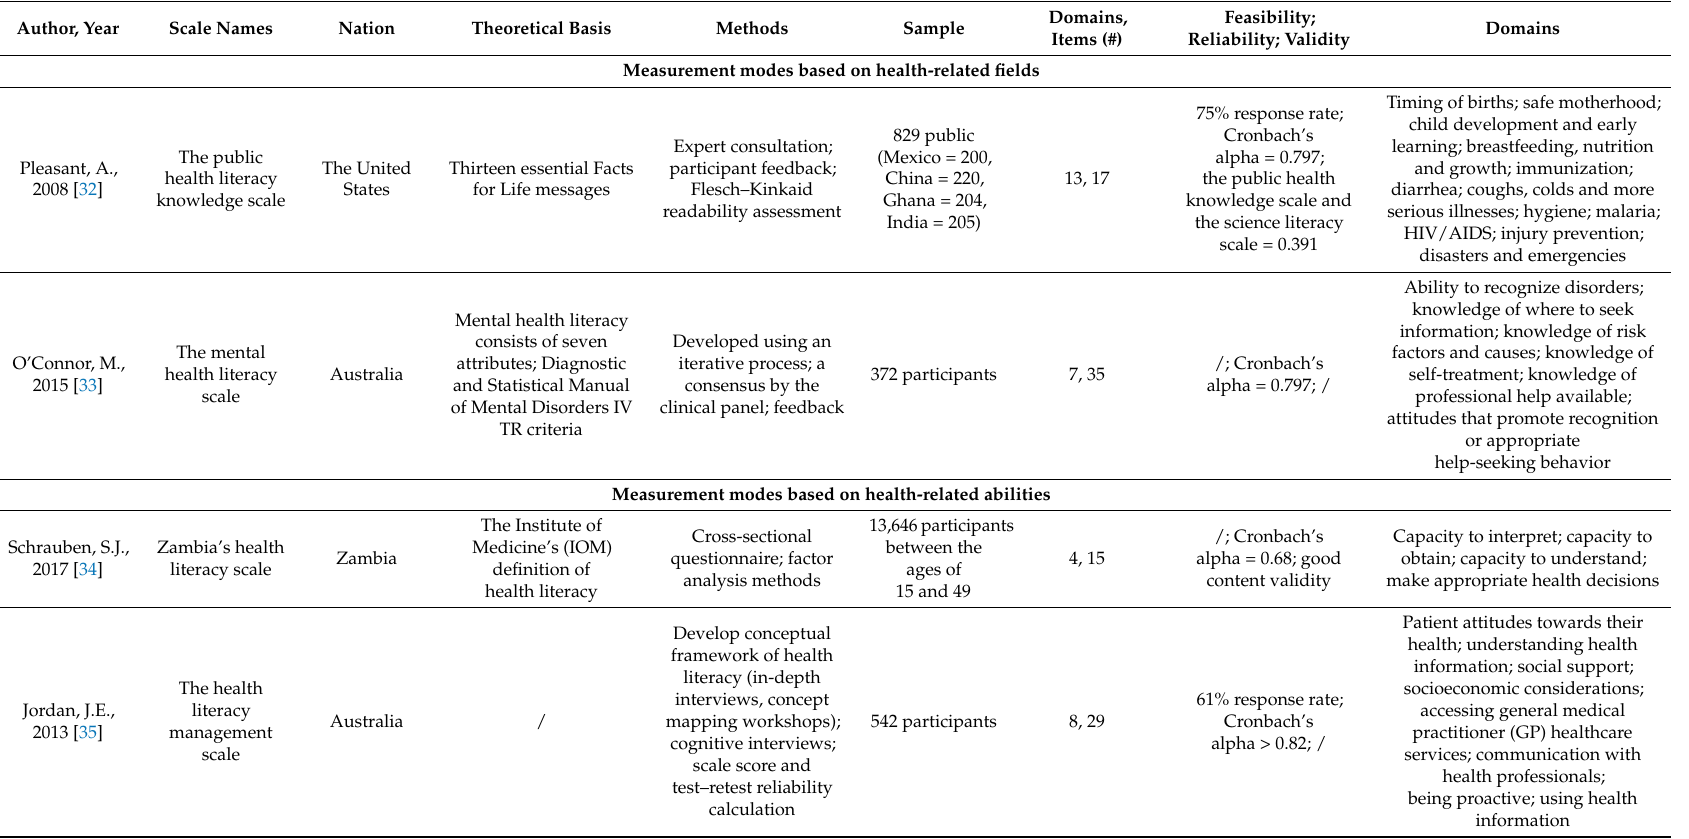
Table 1. Main instrument characteristics of tools assessing health literacy among the general population in this literature